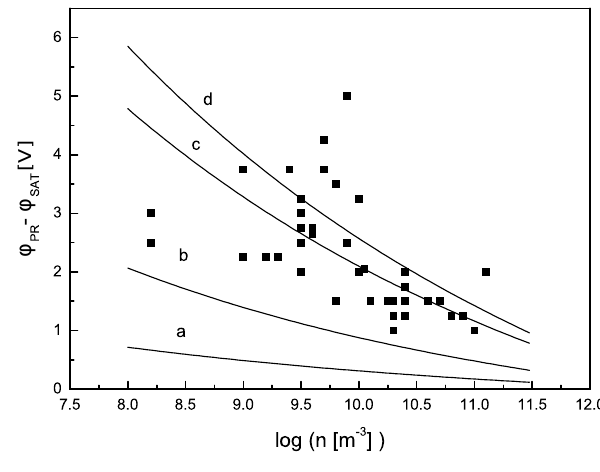
Fig. 4. Potential difference between the probe and the satellite as a function of ambient plasma